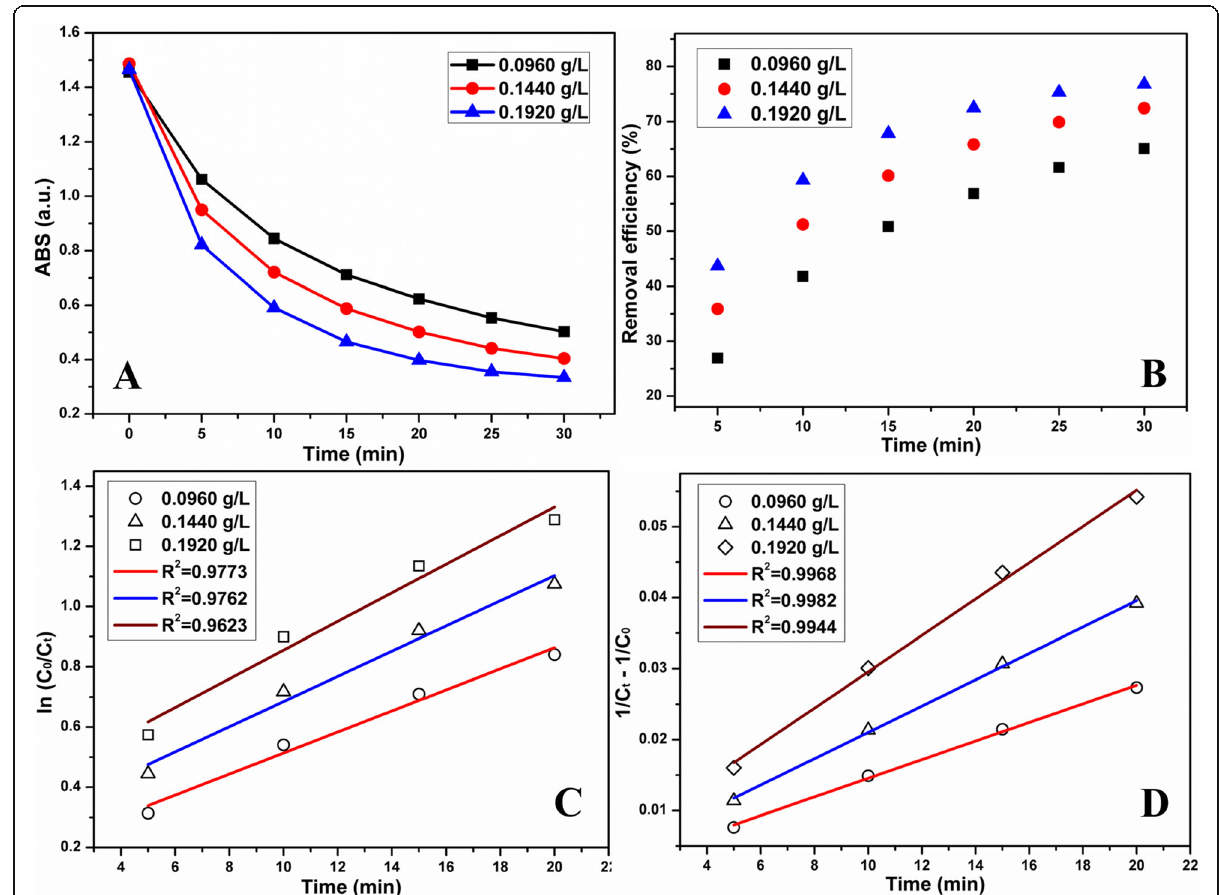
Fig. 6 The time-dependent a absorption intensity of TCH and b removal efficiency by different amounts of MnO 2 NPs/ESM treatment. c Linear first-order kinetic plots and d linear second-order kinetic plots by different amounts of MnO 2 NPs/ESM treatment. (Conditions: initial concentration of TCH was 50 mg/L, controlled pH was